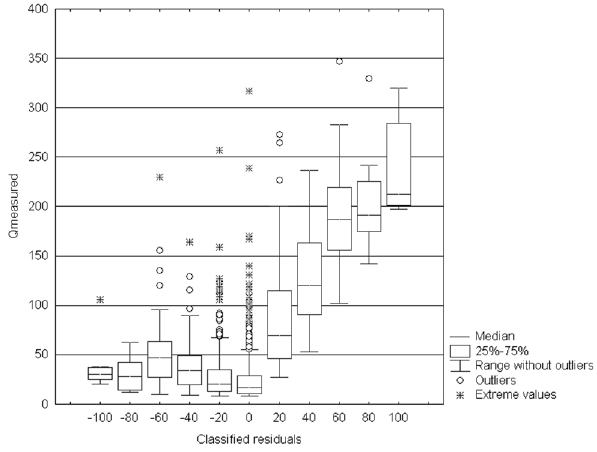
Fig. 7. Box-and-Whisker plot for measured discharge versus classi- fied residuals (classes named according to their lower